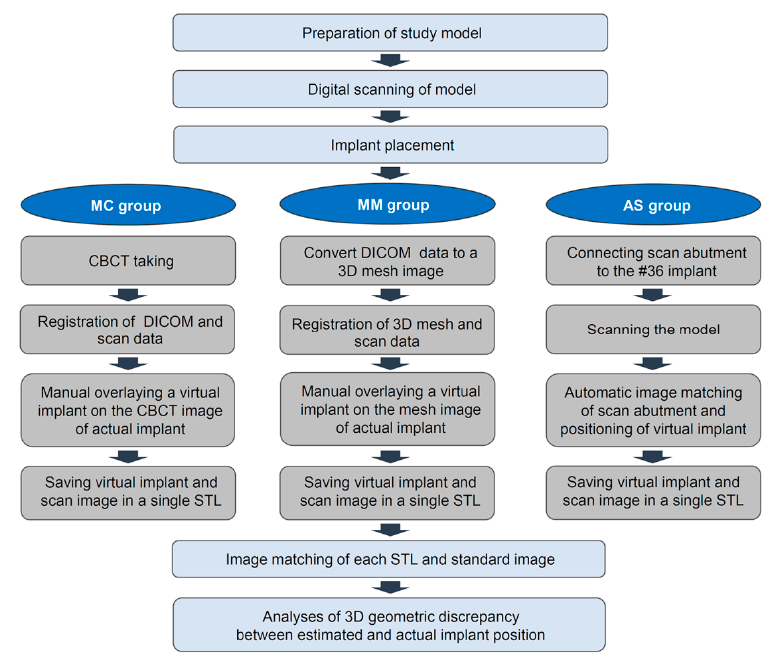
Figure 1. Workflow for this study. MC: Manual matching on a CBCT image; MM: Manual matching on a mesh model of a CBCT image; AS: Automatic matching on a scan abutment of the scan image.